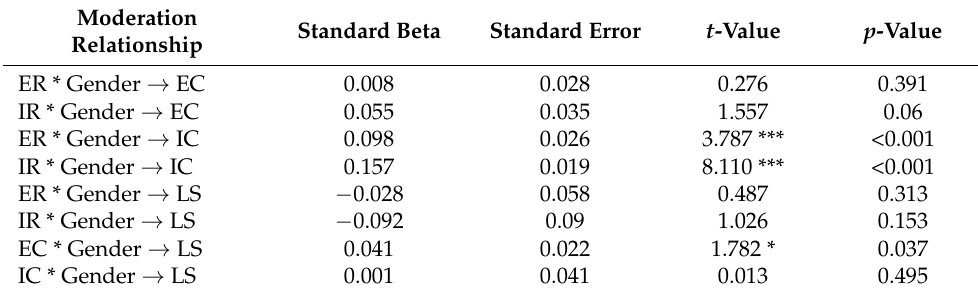
Table 6. Moderating effects of the model.